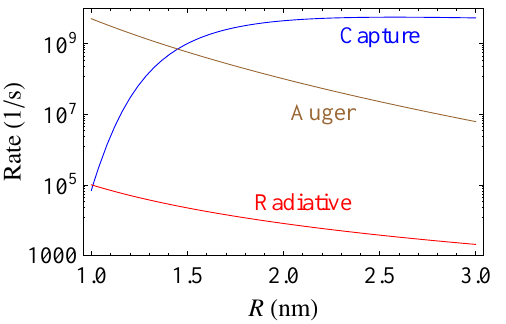
Figure 3. Calculated rates of carrier trapping on dangling bonds compared to the rates of radiative phonon-assisted transitions and Auger recombination in Si